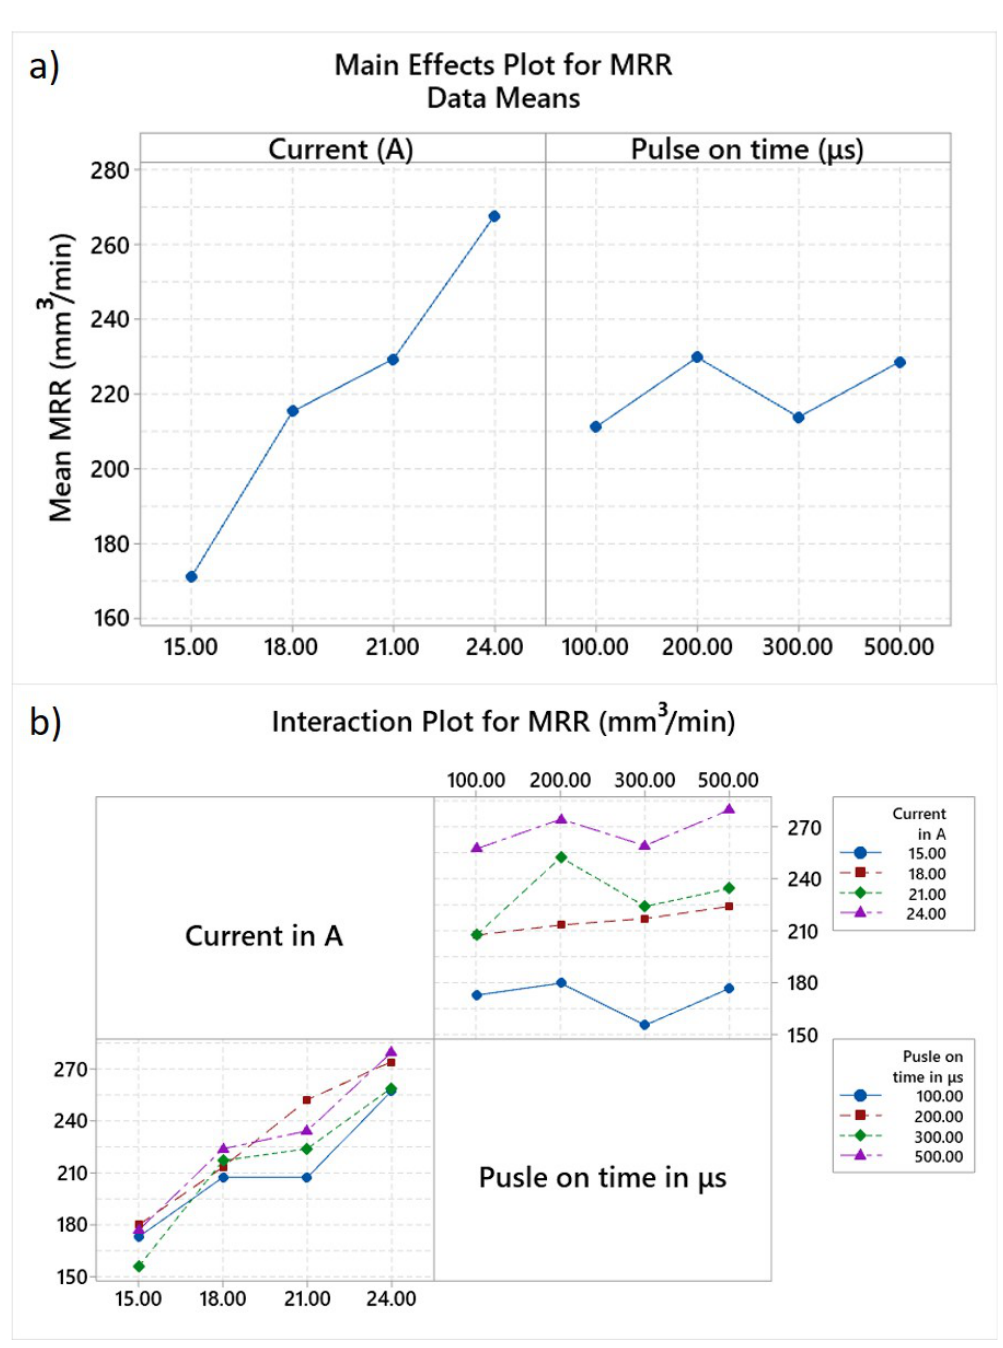
ff ects plot for MRR . ( b ) Interaction plot for MRR Figure 1. ( a ) Main effects plot for MRR. ( b ) Interaction plot for MRR. Figure 1. ( a ) Main e